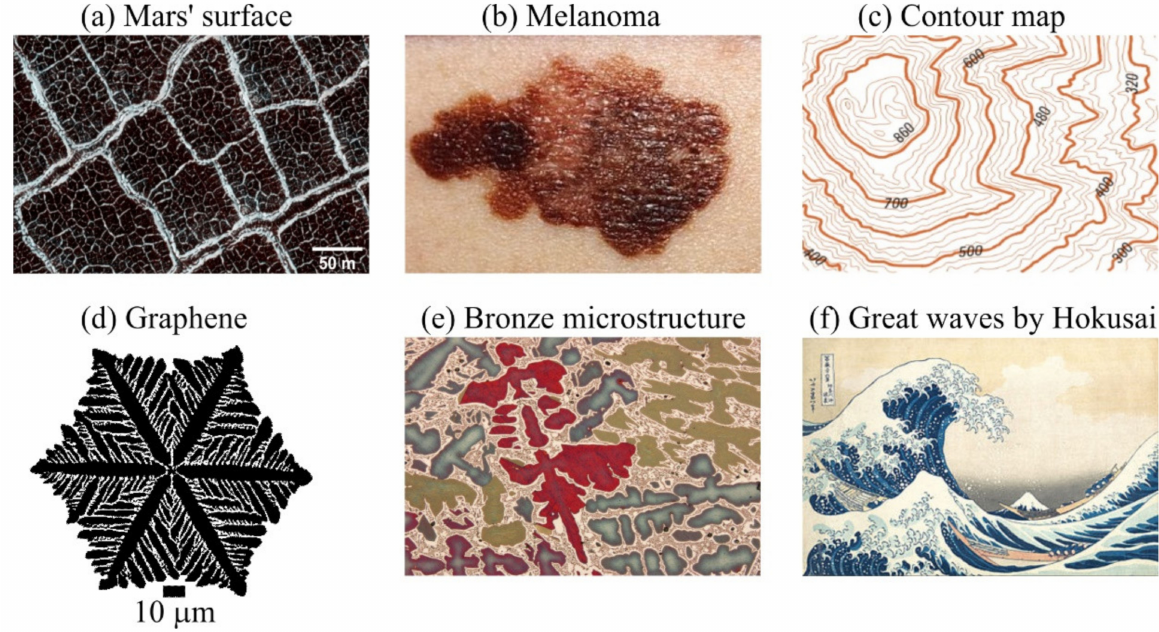
Figure 3. Examples of arbitrary patterns. ( a ) Mars’ surface; Credit: NASA [9]. ( b ) Melanoma; Credit: Wikipedia [10]. ( c ) Con- tour map; Credit: [11]. ( d ) Microstructure of graphene; Credit: [12]. ( e ) Microstructure of bronze: Credit: Wikipedia [13]. ( f ) Artwork; Credit. Wikipedia. Hokusai